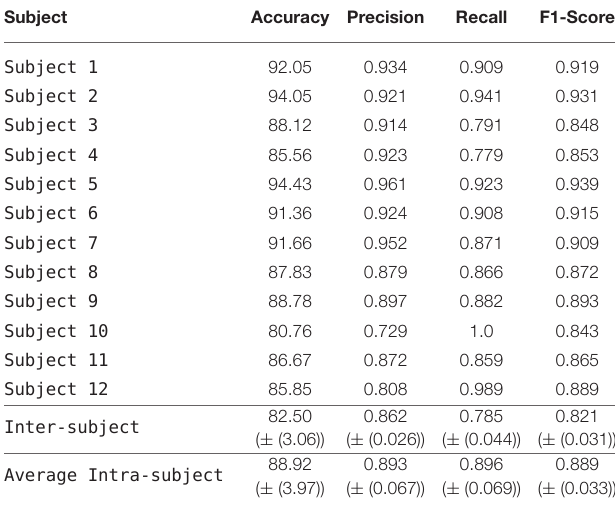
TABLE 1 | Performance of the model on raw data. TABLE 2 | Performance of the model on scalograms of raw